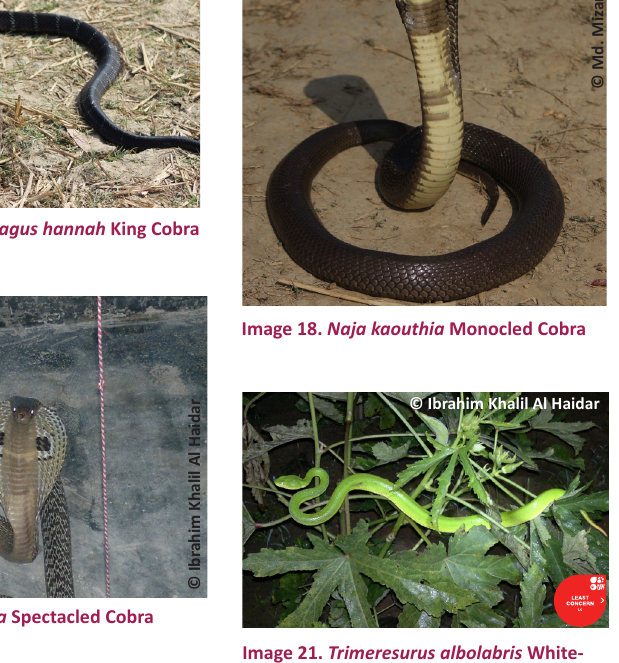
Image 19. Bungarus fasciatus Banded Krait